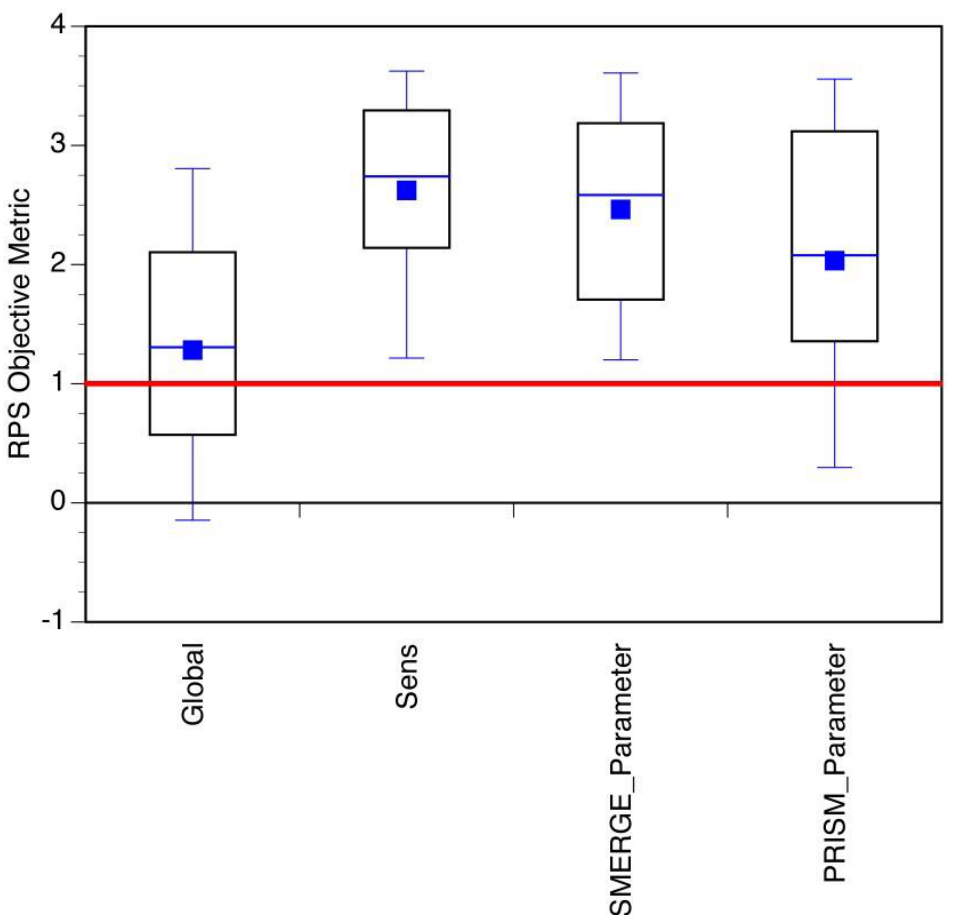
Figure 4. Combined RPS value from final year-by-year series (2016 to 2018). Red line represents an RPS = 1.00, which is the threshold for an acceptable simulation.